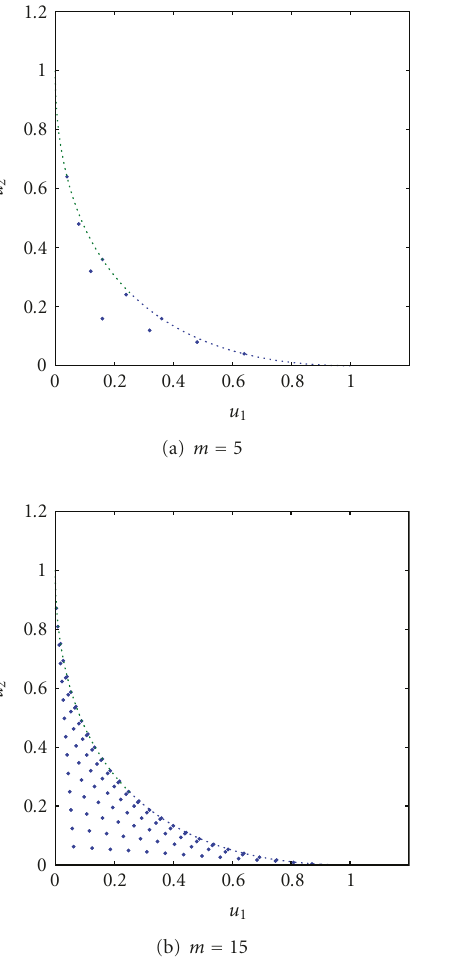
Figure 4: Payo ff s that can be achieved by the manager with noisy observation. (a) (cid:2) = 0 . 1. (b) (cid:2) = 0 .